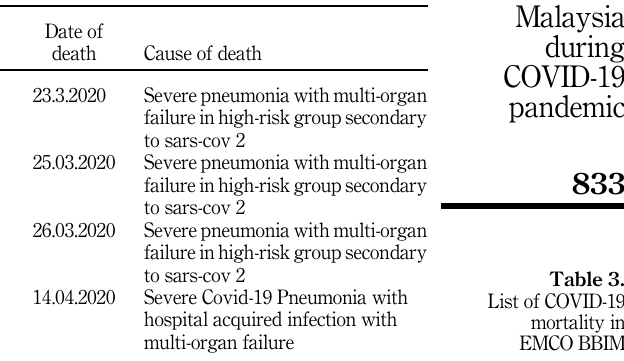
Table 3. List of